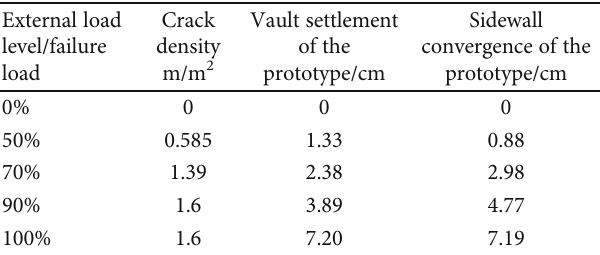
Figure 6: Strain data of the unstrengthened condition ( με = 10 ‐ 6 ). Table 3: The relationship between load, fracture density, vault settlement, and sidewall convergence.